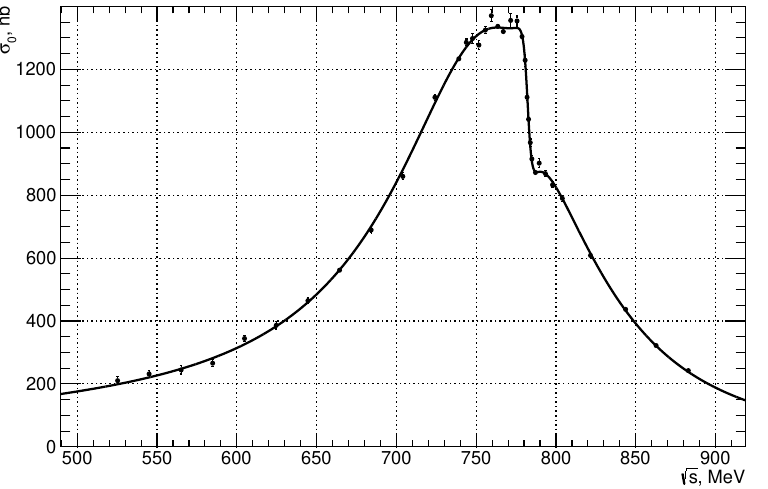
Figure 12 . The dependence of the Born cross section of the e + e (cid:0) ! (cid:25) + (cid:25) (cid:0) process on energy, dots with errors are data, curve is the (cid:12)t